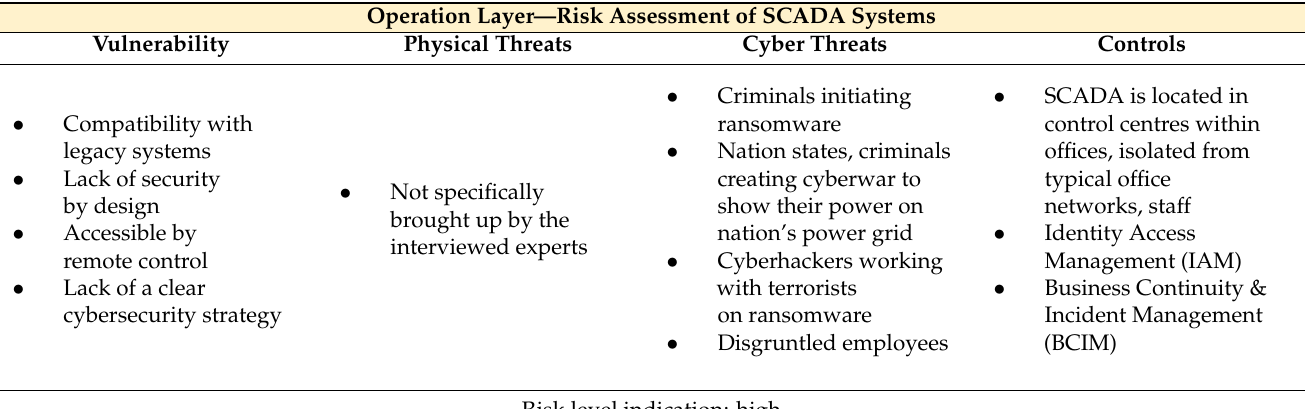
Table 11. Risk assessment for SCADA